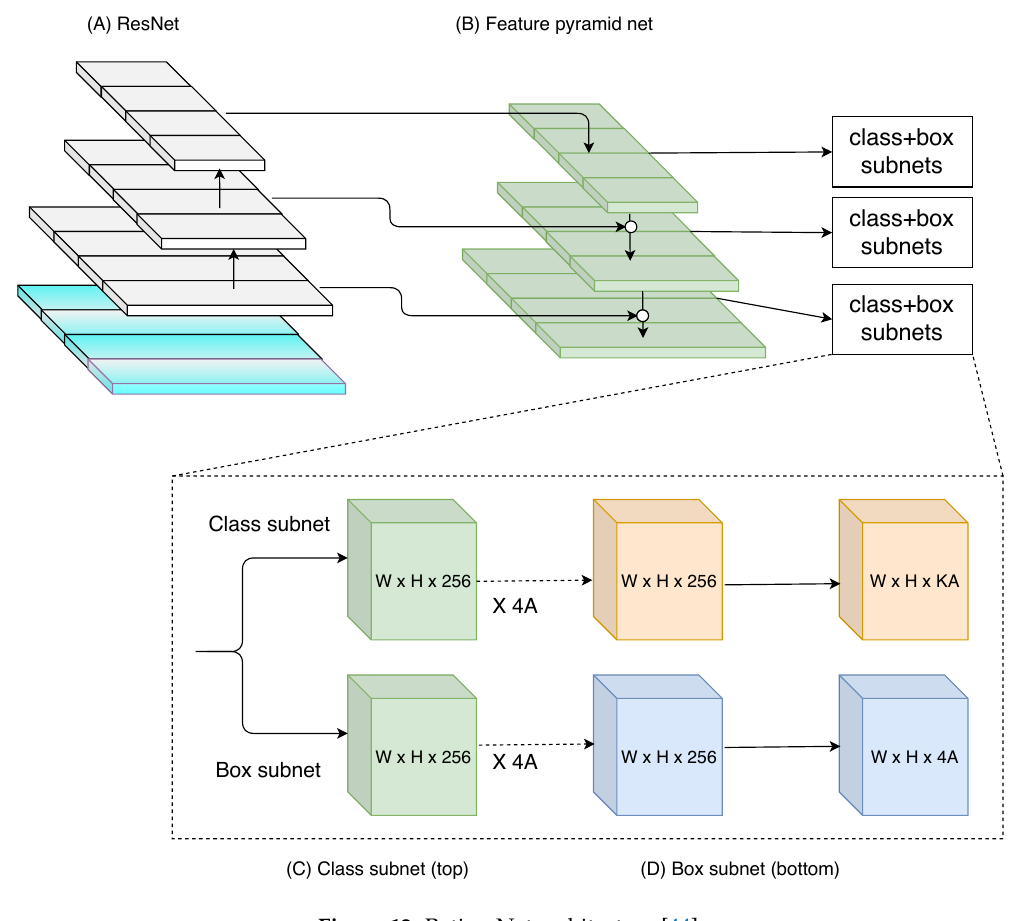
Figure 12. Retina-Net architecture